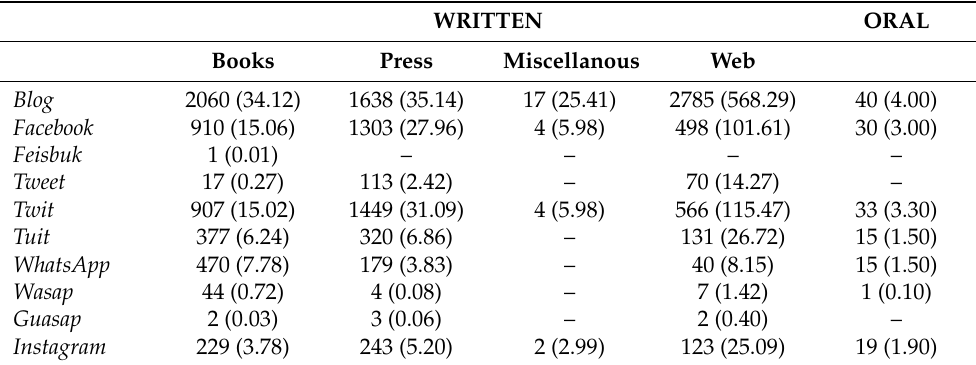
Table 6. Raw and normalized frequencies of the terms under analysis in different registers ( CORPES XXI corpus). WRITTEN ORAL Books Press Miscellanous